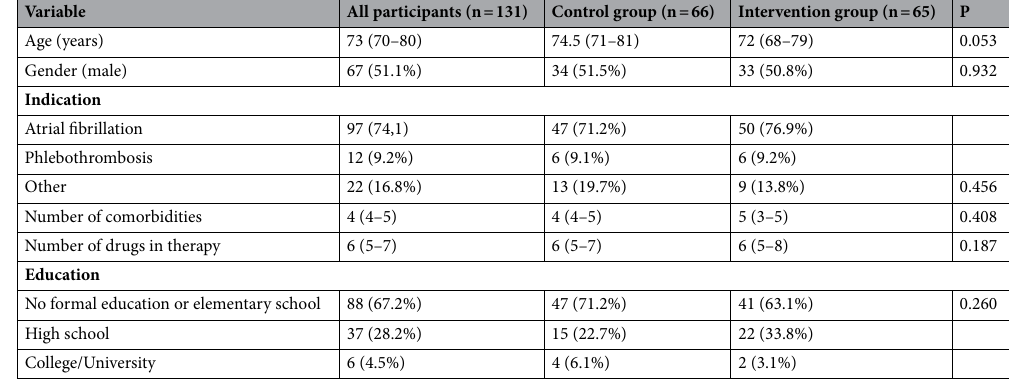
Table 1. Baseline sociodemographic and clinical characteristics of the study participants. Data are presented as n (%) or median (interquartile range). P values obtained by Mann–Whitney U test for numerical data or Chi-squared test for categorical